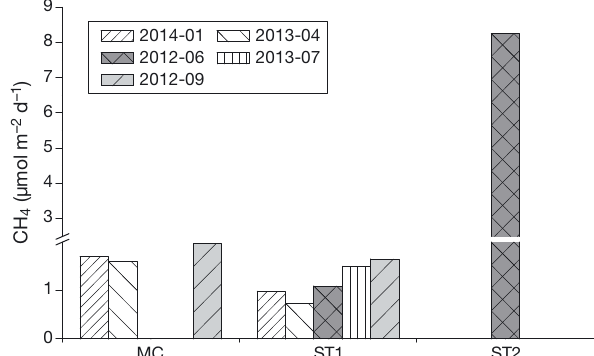
Fig. 6. Sediment−water CH 4 fluxes (µmol m −2 d −1 ) at Stns MC, ST1, and ST2 in Sanggou Bay (see Fig. 2) in different seasons and years